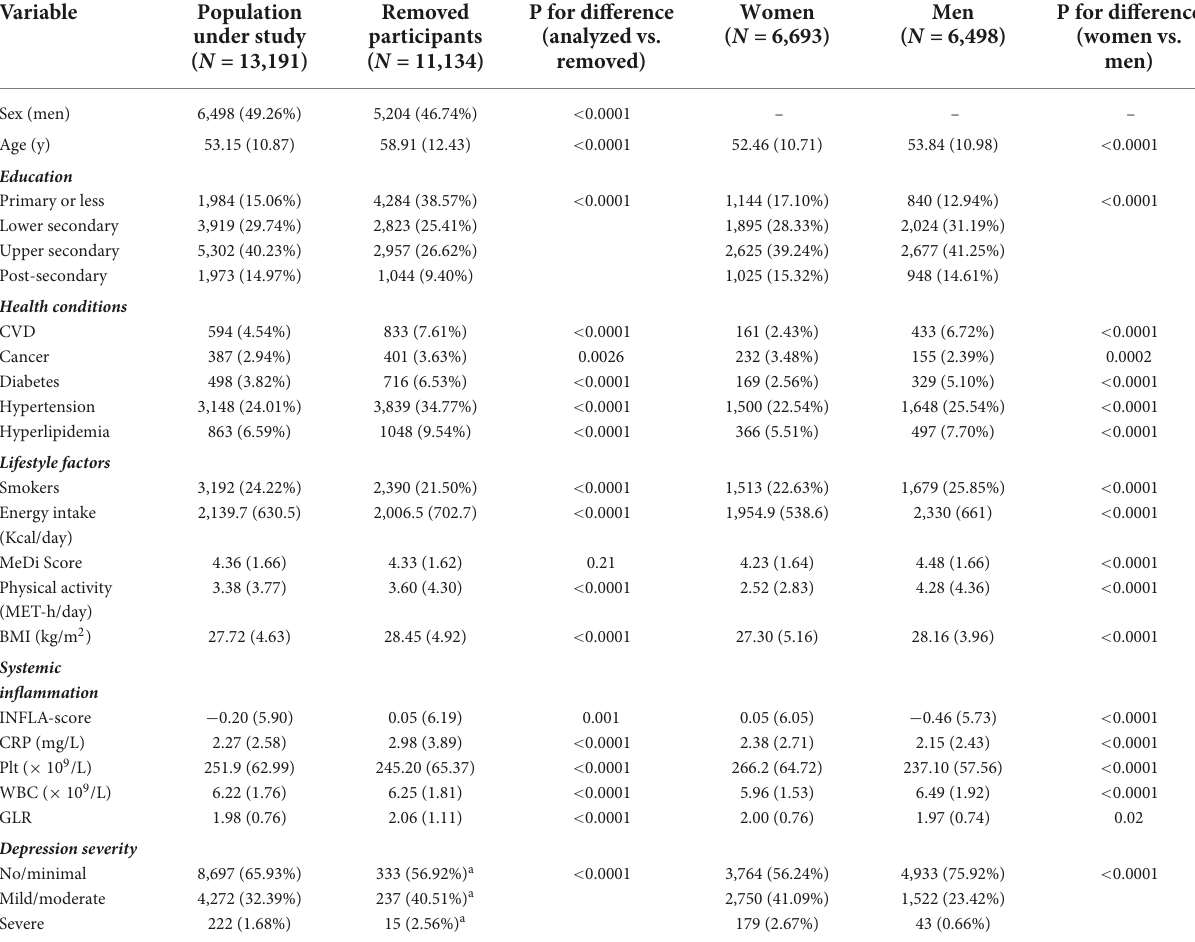
TABLE 1 Baseline characteristics by gender of the analyzed Moli-sani population ( N = 13,191).